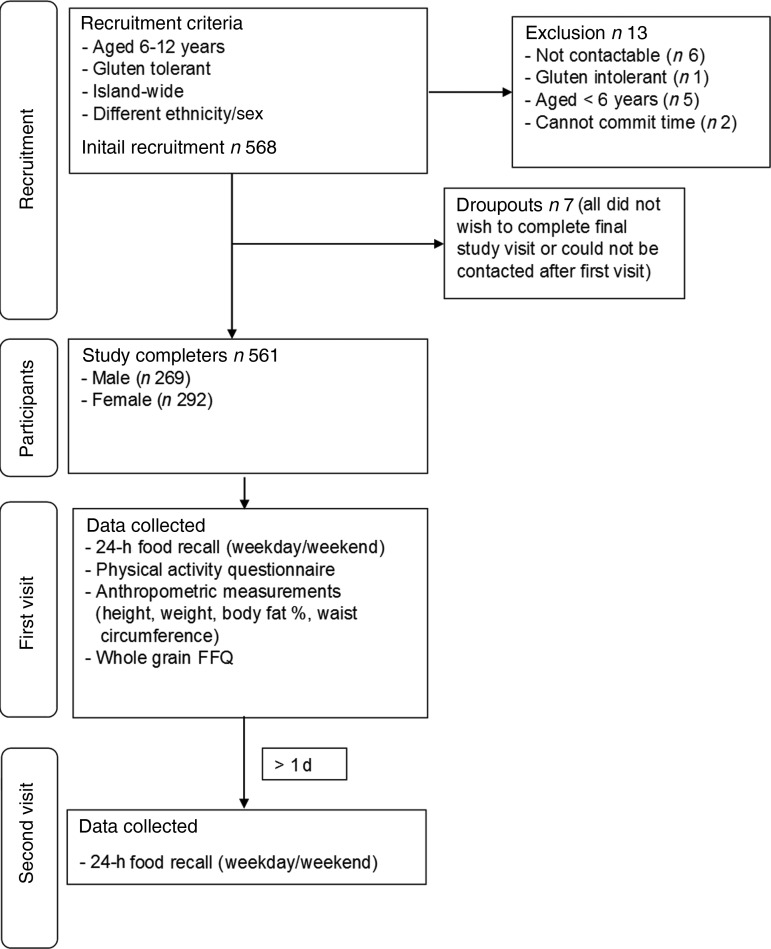
Overview of participants’ recruitment, selection and study design.